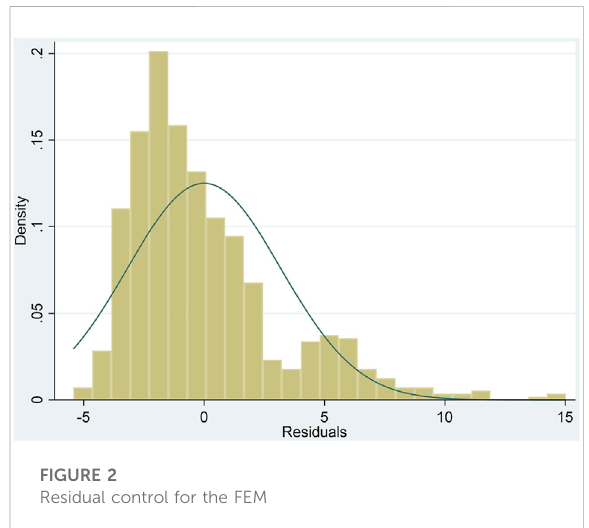
FIGURE 2 Residual control for the